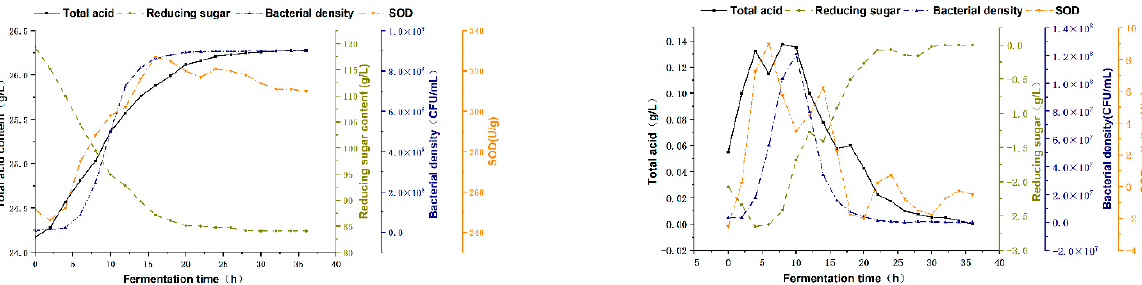
Figure 3. ( A ) The trend change of lactic acid bacteria density, sugar content, total acid content, and SOD activity during the fermentation process; ( B ) Specific growth rate, sugar consumption